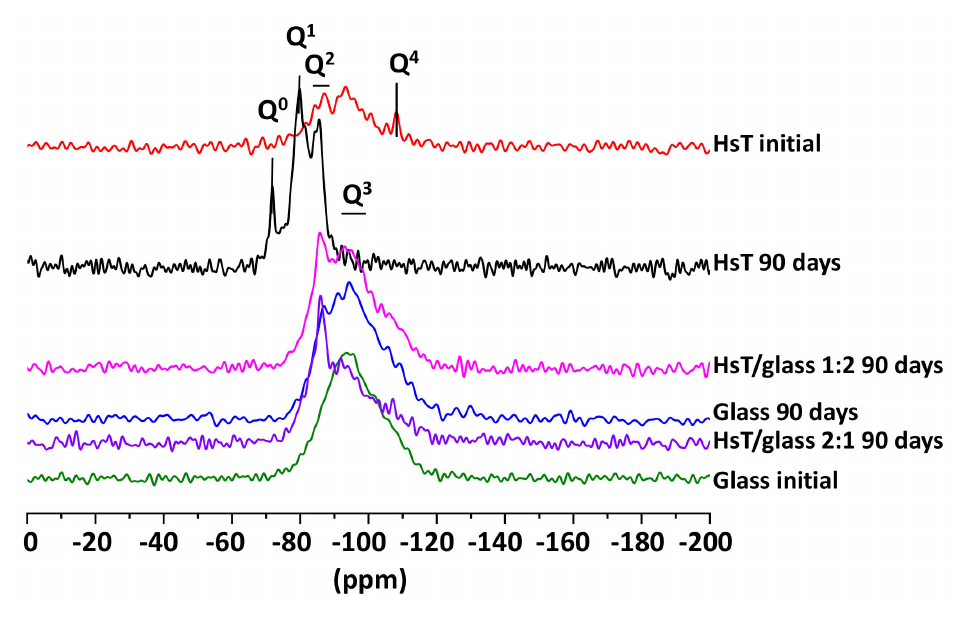
Figure 6. NMR of the 27 Si cores of the initial HsT and glass waste and binary mixtures at 90